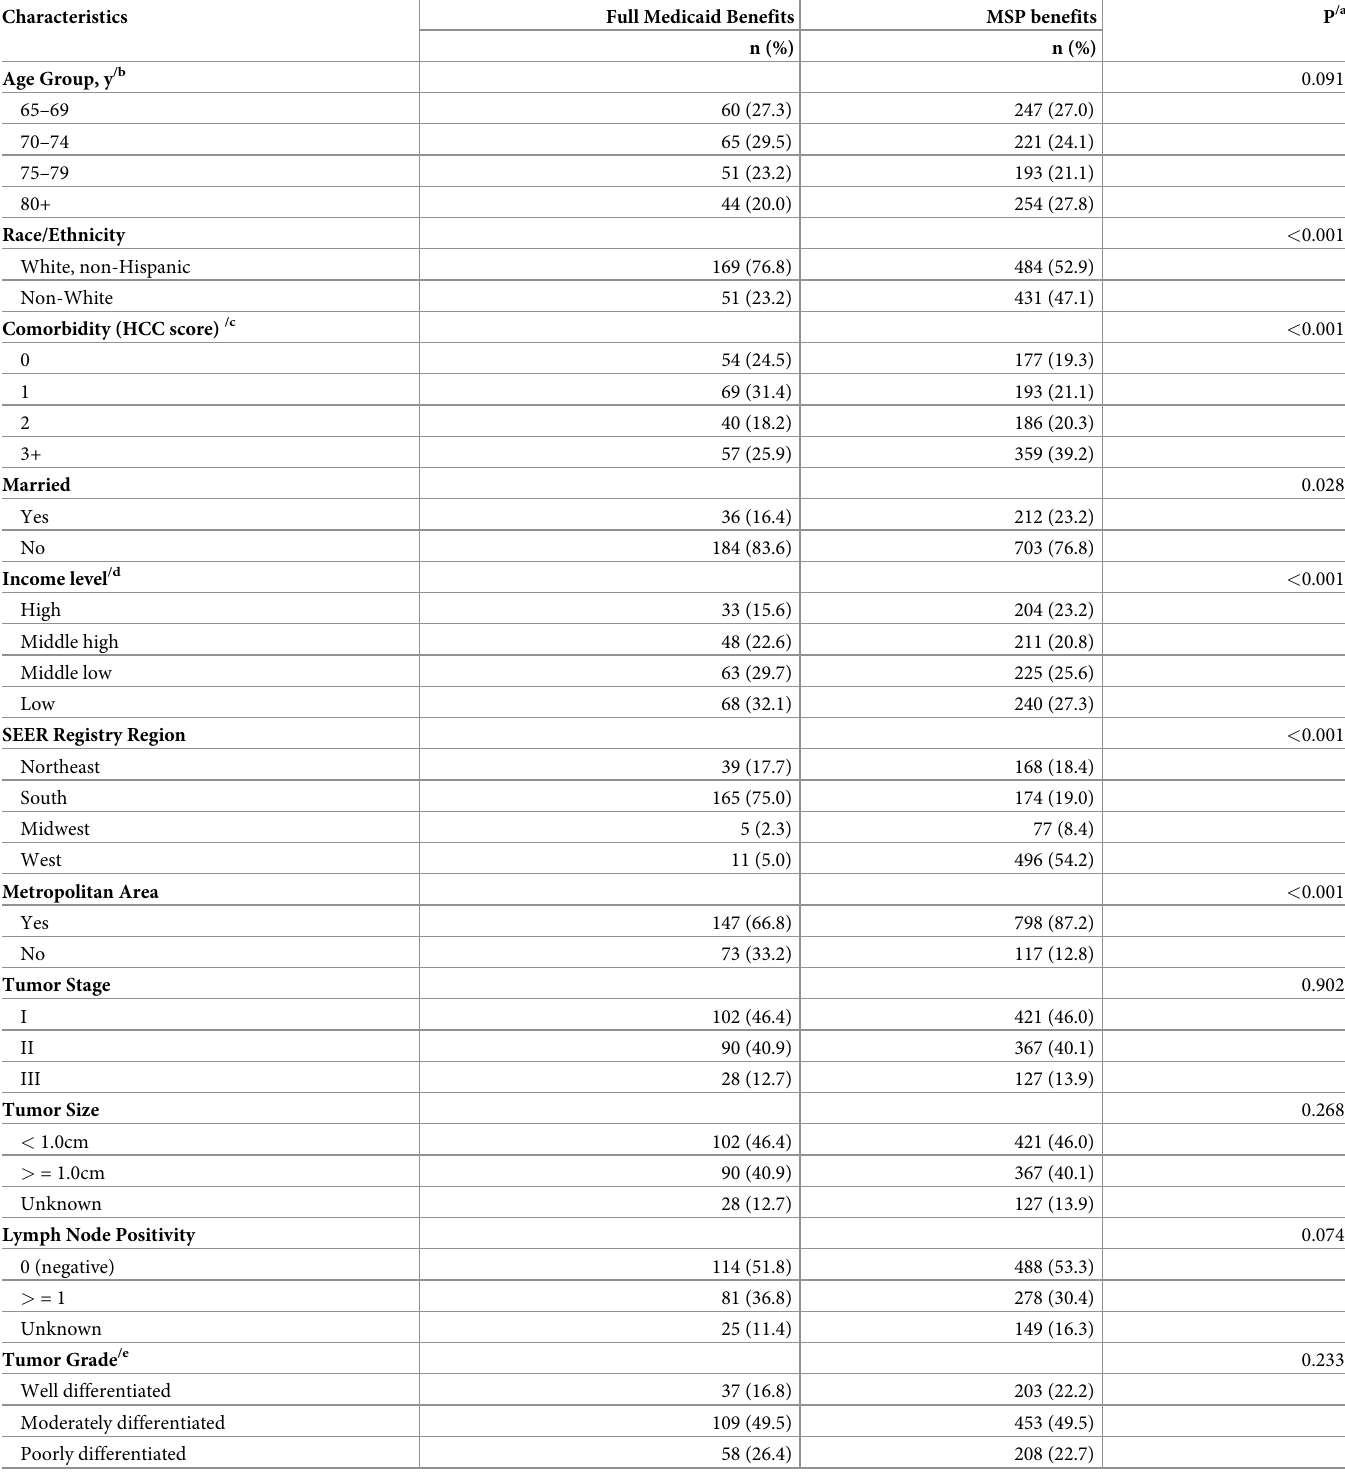
Table 1. Baseline characteristics of Medicare and Medicaid dual eligible beneficiaries diagnosed with hormone receptor-positive early stage breast cancer from 2007 to mid-2009, by the source of dual benefits.